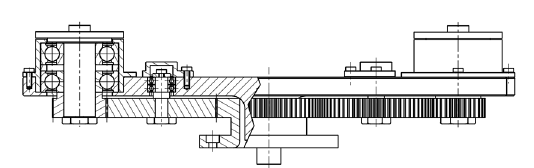
Figure 1. Mechanical Design of the planetary mill.